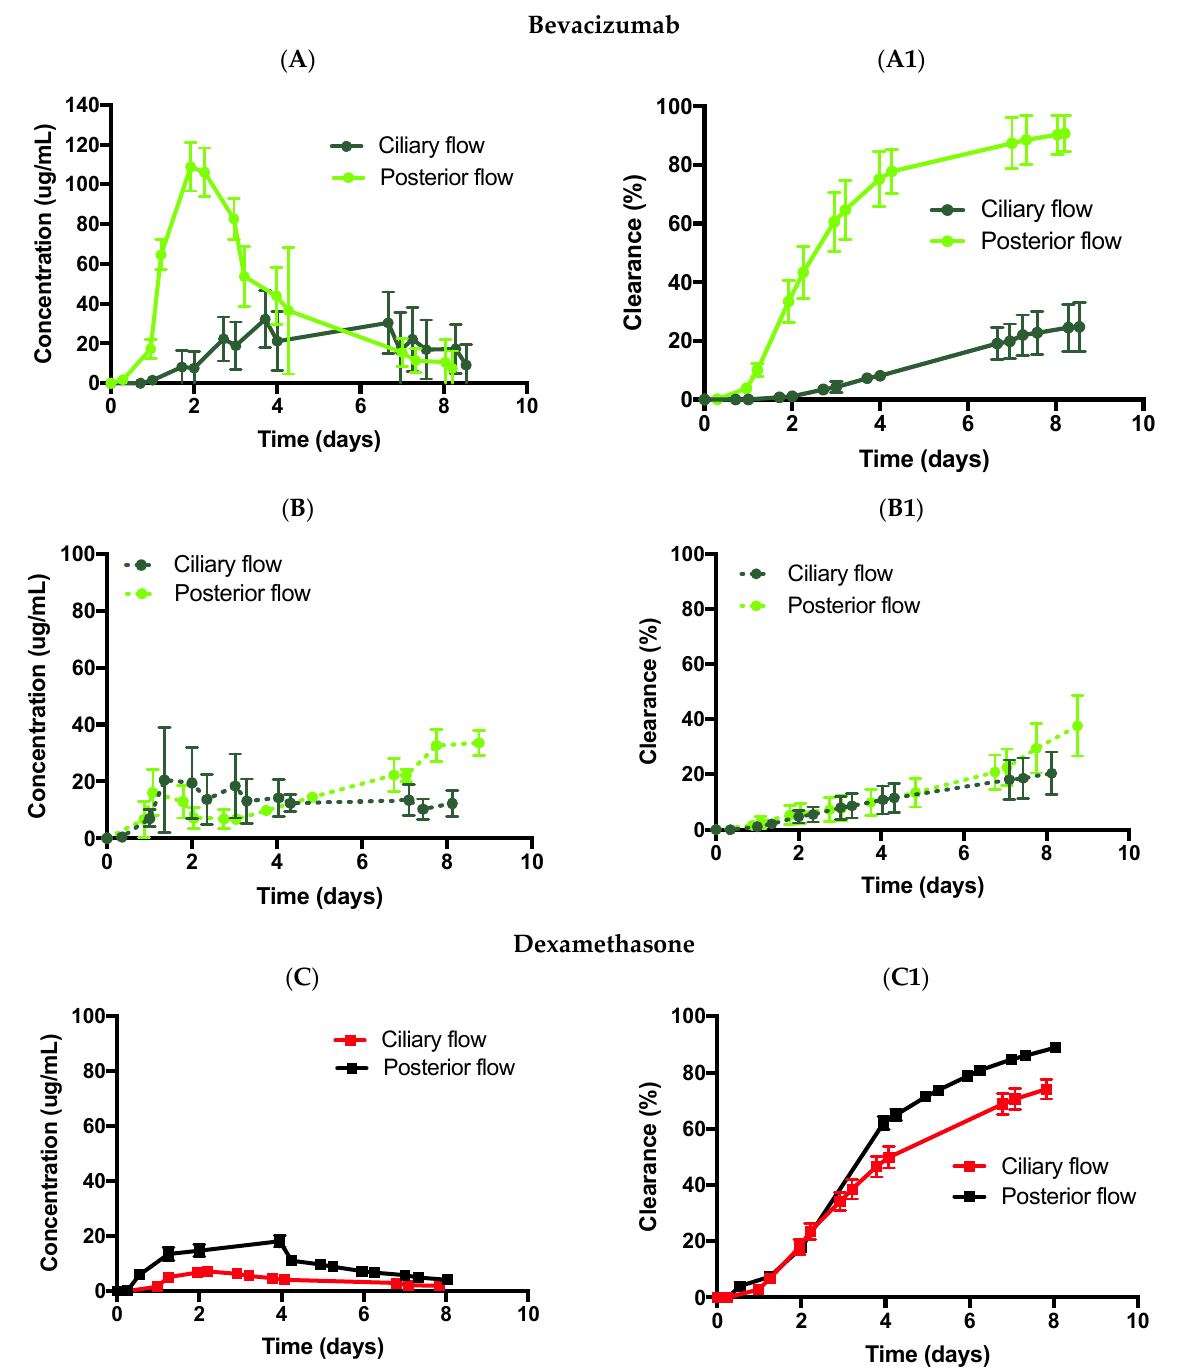
Figure 6. Effect of flow using the posterior inflow model and ciliary inflow model with ( A , A1 , B , B1 ) bevacizumab (1.25 mg, 50 µL) in ( A , A1 ) PBS, pH 7.4 and ( B , B1 ) SVF, and ( C , C1 ) dexamethasone (0.1 mg, 100 µL) in PBS. All data are presented as the mean (n = 5) and standard deviation (±STD). When injected in the SVF (Figure 6B,B1), bevacizumab displayed C max values of 37.6 ± 10.9 µg/mL (day 8), with a predicted half-life value of 10.8 days (R 2 : 0.810), and drug release of 37.6 ± 10.9% by ~day 9, respectively. Similarly, in SVF, the posterior inflow model reduced the half-life value from 19.2 to 10.8 days (reduction by ~44%), demonstrat- ing the effect of flow convection. In a previous publication [19], the clearance half-life of bevacizumab with a similar dose was 10.1 ± 0.7 days, indicating similar results when using